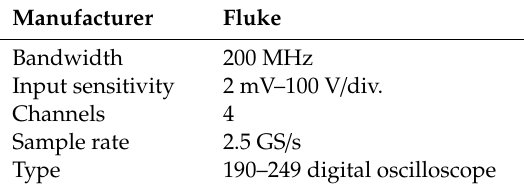
Table 4. Details of digital storage oscilloscope.